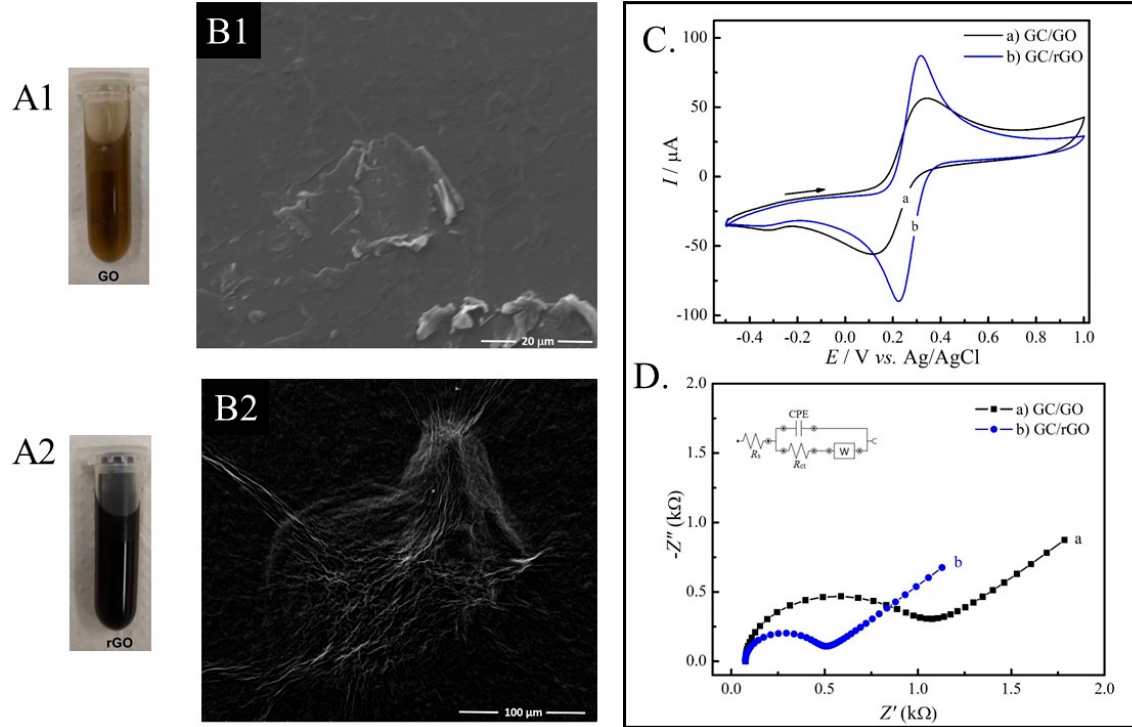
Figure 1. Visual characterization of GO ( A1 ) and rGO ( A2 ) suspensions. SEM images of GO ( B1 ) and rGO ( B2 ). Electro- chemical characterization of electrodes modified with GO and rGO materials using CV ( C ) and EIS ( D ).